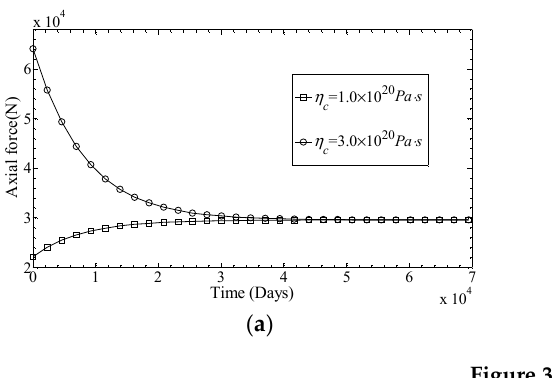
Table 1. Experiment parameters.